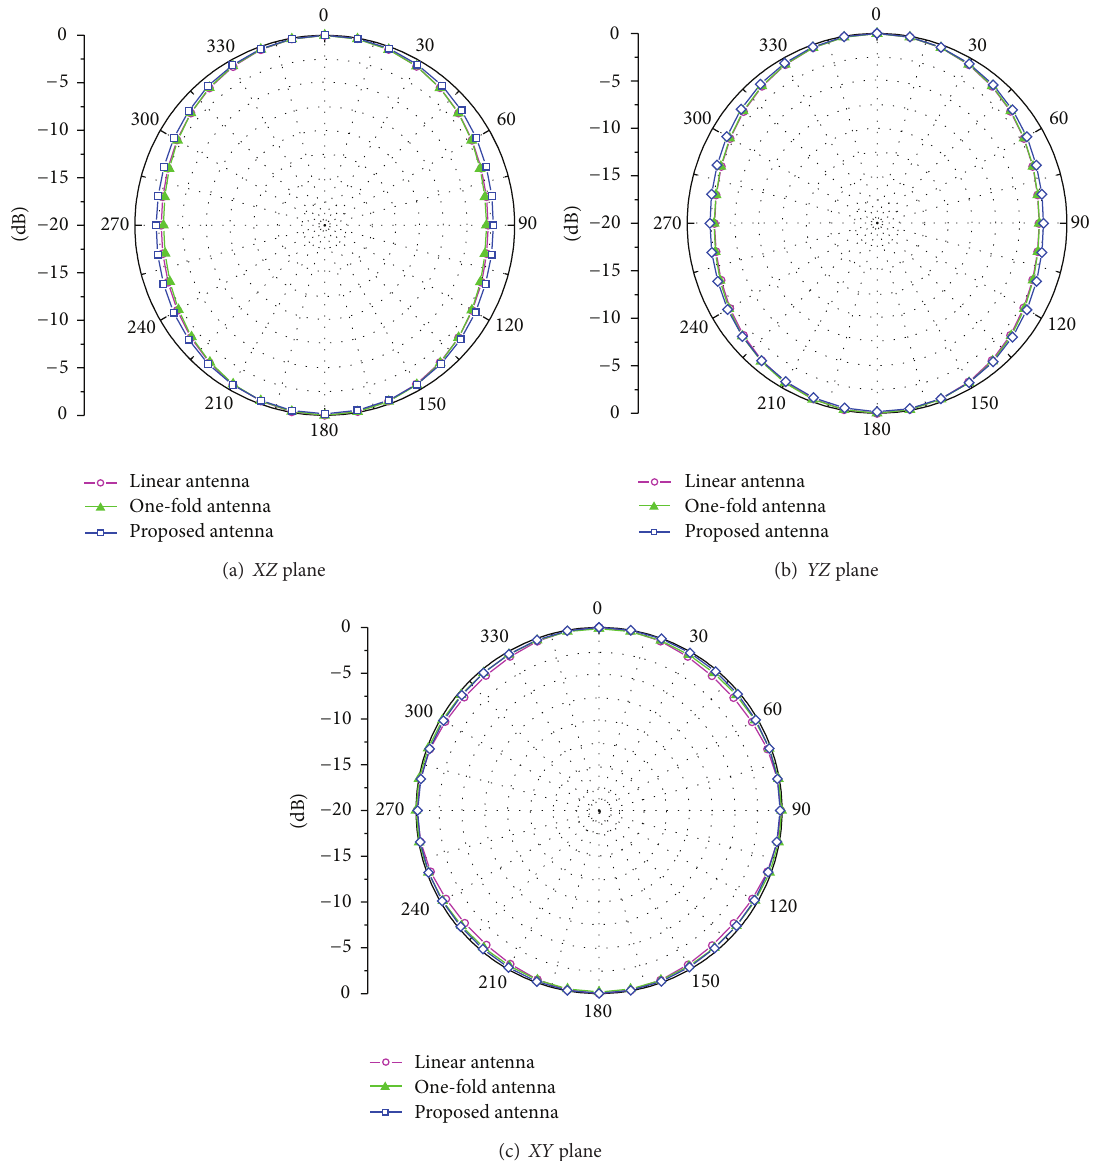
Figure 5: Simulated normalized radiation patterns of the three tag antennas.